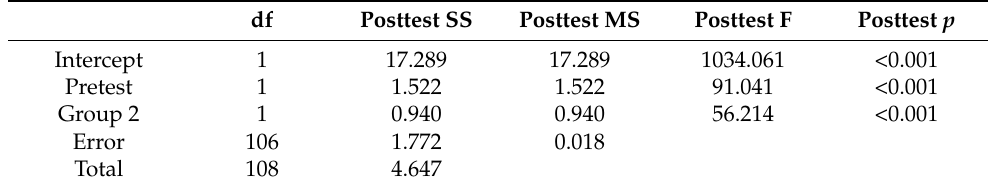
Table 5. The analysis of covariance with pretest control.